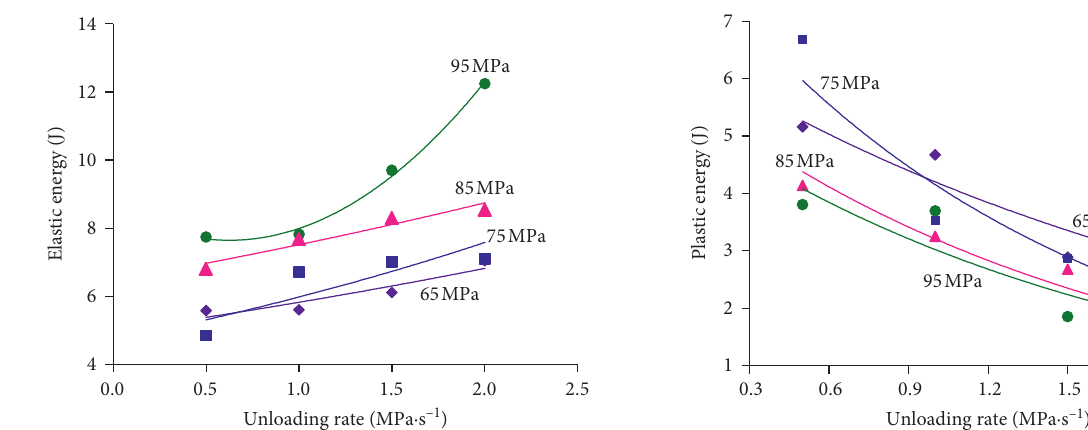
Figure 11: Relationship between the plastic energy accompanying with impact and unloading rate (the numbers in figure represents the preloaded axial static stress of